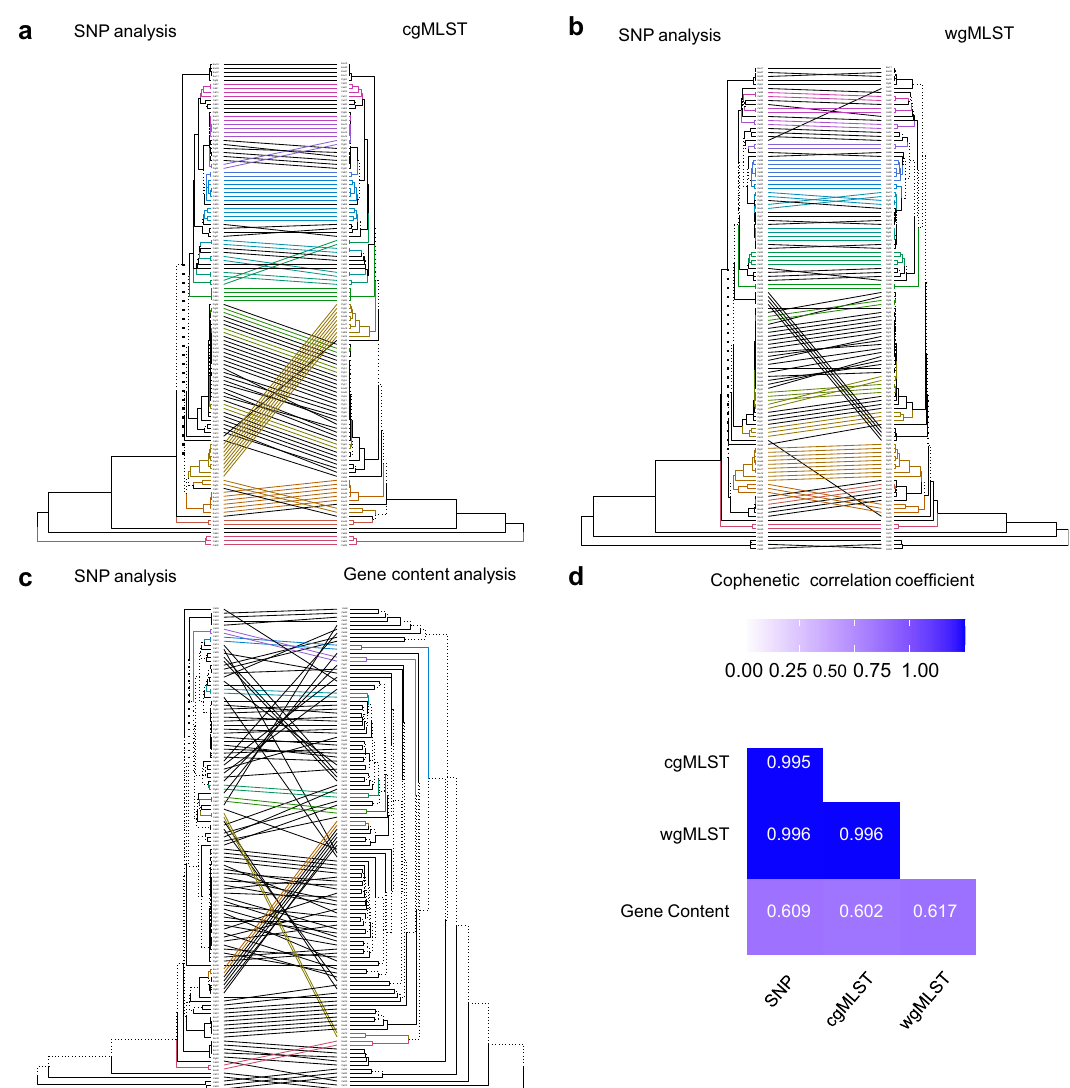
Fig. 2 Comparison of UPGMA dendrograms from four WGS-based subtyping methods. a – c shows the comparison between dendrograms produced from core SNP analysis and cgMLST ( a ), wgMLST ( b ), and gene content analysis ( c ), respectively. d shows the pairwise Cophenetic correlation coef fi cients of dendrograms. In a – c , the same tips/isolates of two trees are connected using straight lines; the connecting lines and branches are colored to highlight the sub-trees that are present in both dendrograms; the nodes which contain a combination of labels/items that are only present in one of the two trees are highlighted using dashed